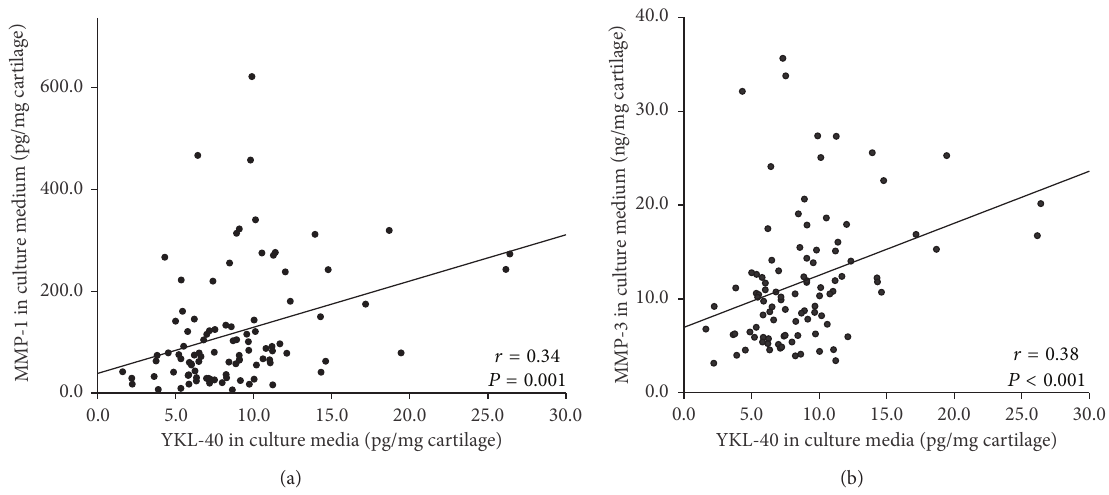
Figure 3: YKL-40 release from cultured OA cartilage correlated with MMP-1 and MMP-3. Cartilage samples from 97 OA patients were incubated for 42h. Concentrations of YKL-40 released from OA cartilage into the culture media correlated positively to those of (a) MMP-1 and (b) MMP-3 ( 𝑟 = 0.34 , 𝑃 = 0.001 and 𝑟 = 0.38 , 𝑃 < 0.001 ,